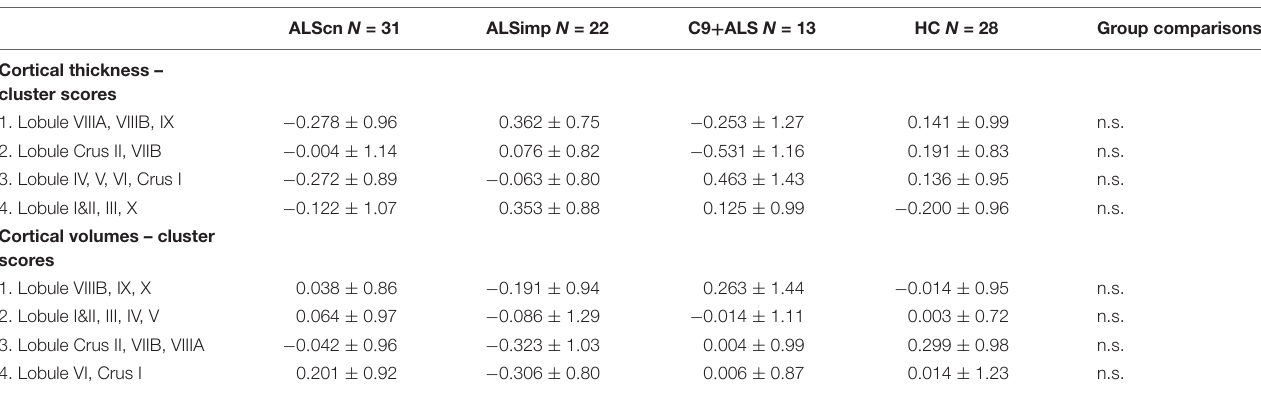
TABLE 4 | Clustering pattern of cerebellar lobules (mean cluster score ± standard